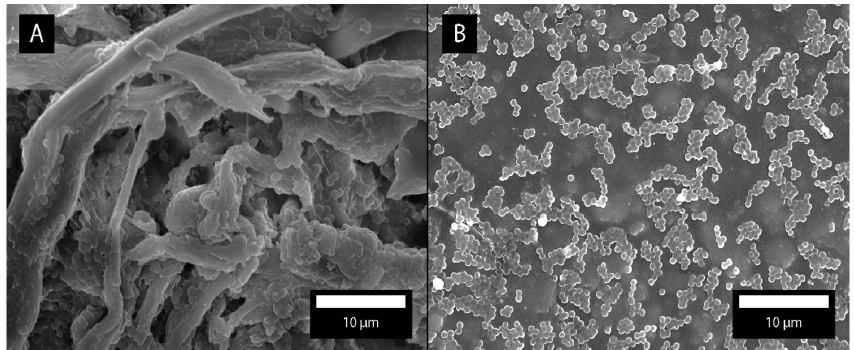
Figure 7. SEM micrographs of natural ( A ) and artificial leather ( B ). The difference in the surface morphology dictates the bacterial adhesion.